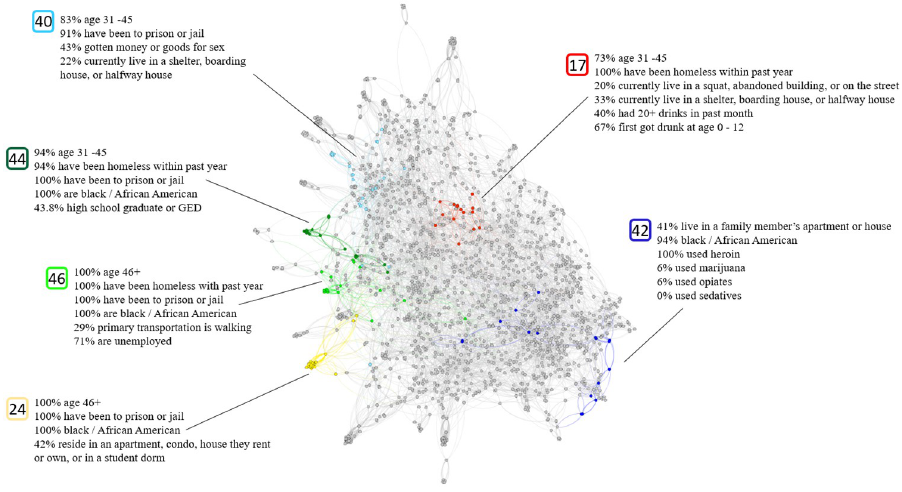
Fig 3. Injected drugs